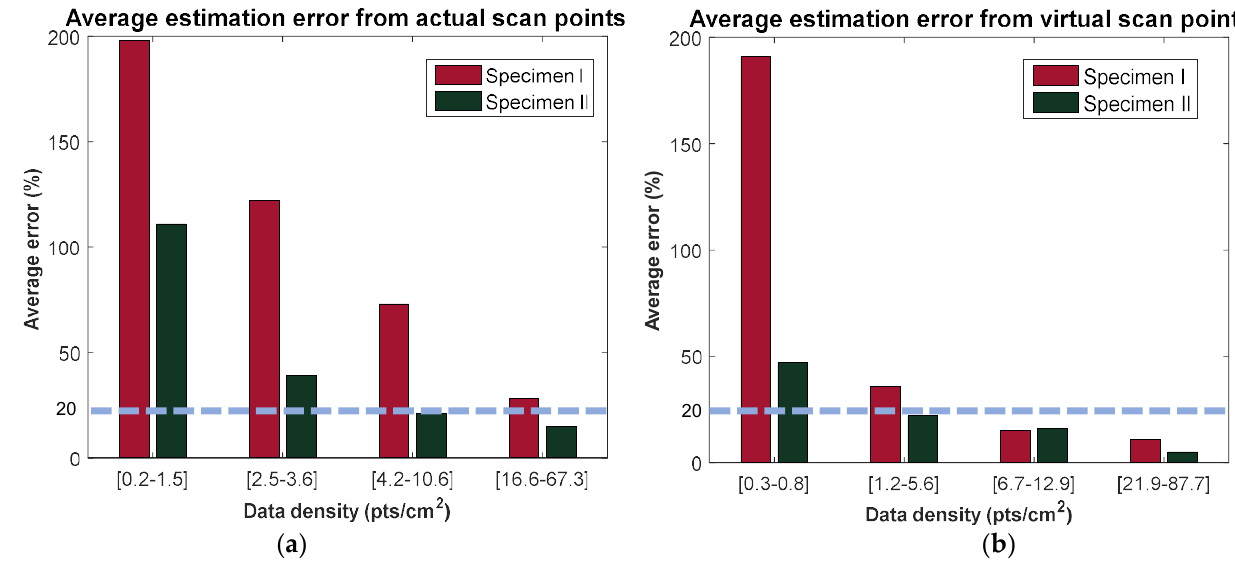
Figure 10. Estimation errors of F F numbers with varying scan densities in specimen I and II: ( a ) average estimation error from actual scan points and ( b ) average estimation error from virtual scan points.